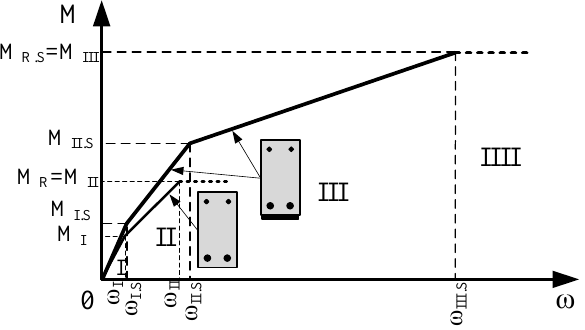
Figure 1. The development of the deflection of the strengthened and unstrengthened beam.